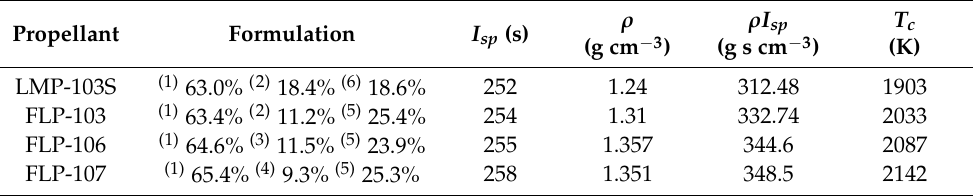
Table 3. ADN-based monopropellants properties [18,22,23] (ideal vacuum I sp by [22] using